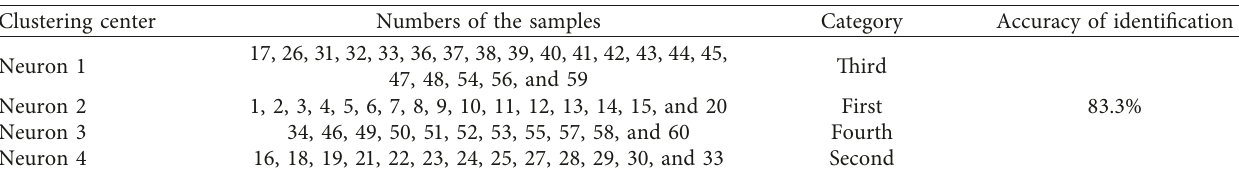
Table 3: Identification results.